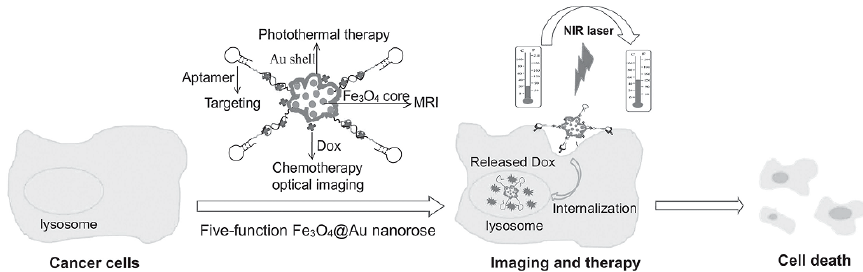
Figure 22. Schematic representation of five-function Fe 3 O 4 -Au nanorose for cancer cell targeting, MR and optical imaging, photothermal and chemotherapy. Sgc8 aptamers are conjugated to the surface of the nanoroses for targeting of CCRF-CEM malignant cells. Anticancer drug (Doxorubicine) is specifically delivered into cancer cells for chemotherapy. Reproduced with permission from [64]. John Wiley and Sons,